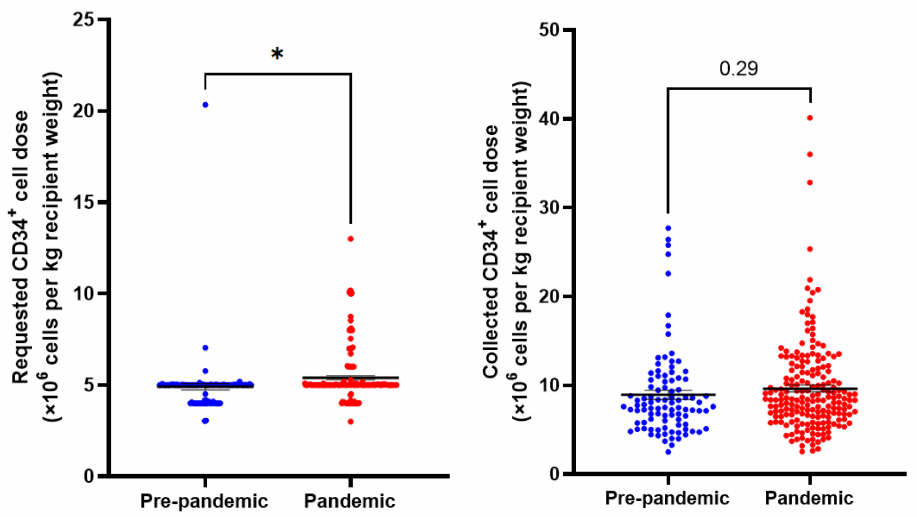
Figure 1. Requested and collected CD34 + cell doses per kg recipient weight in pre-pandemic and pandemic collections. N = 291. Means indicated ± SEM. * = p <